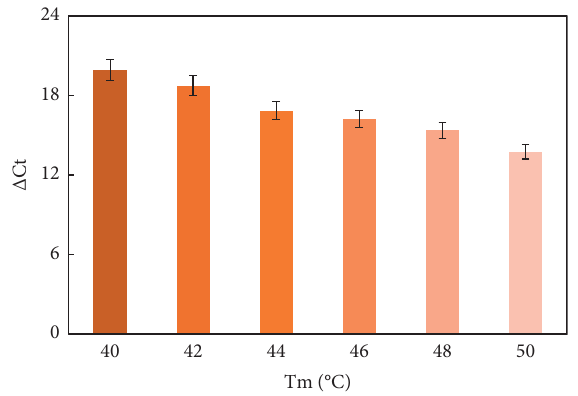
Figure 2: △ Ct value vs the Tm. Experiment conditions: miRNA was 1nM; forward primer was 4 μ M; reverse primer was 2 μ M; and mediator template was 50nM. The detection procedure was carried out as described in the experiment